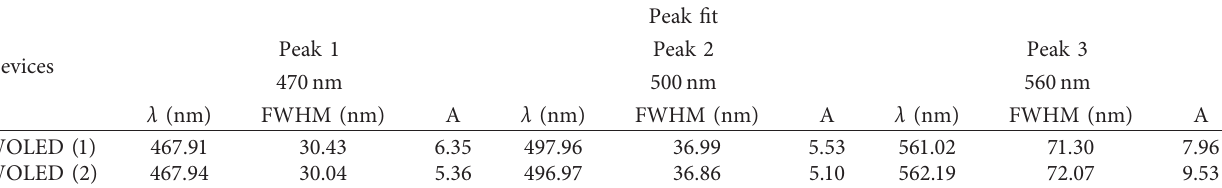
Figure 6: (a) Luminescence spectra of WOLED. (b) Peak fitting of WOLED luminescence spectra. Table 1: Spectral parameters of white OLED devices.